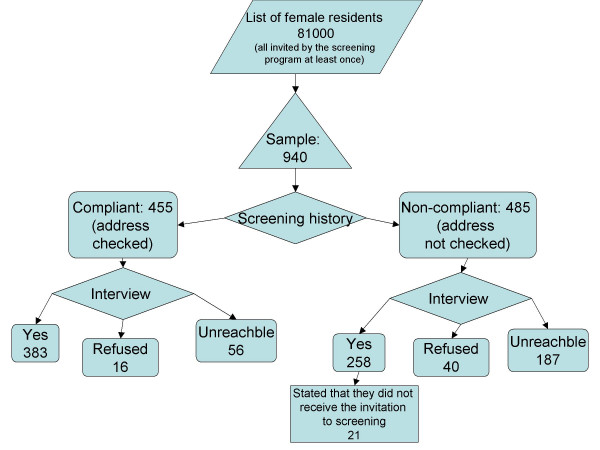
Study flow chart.